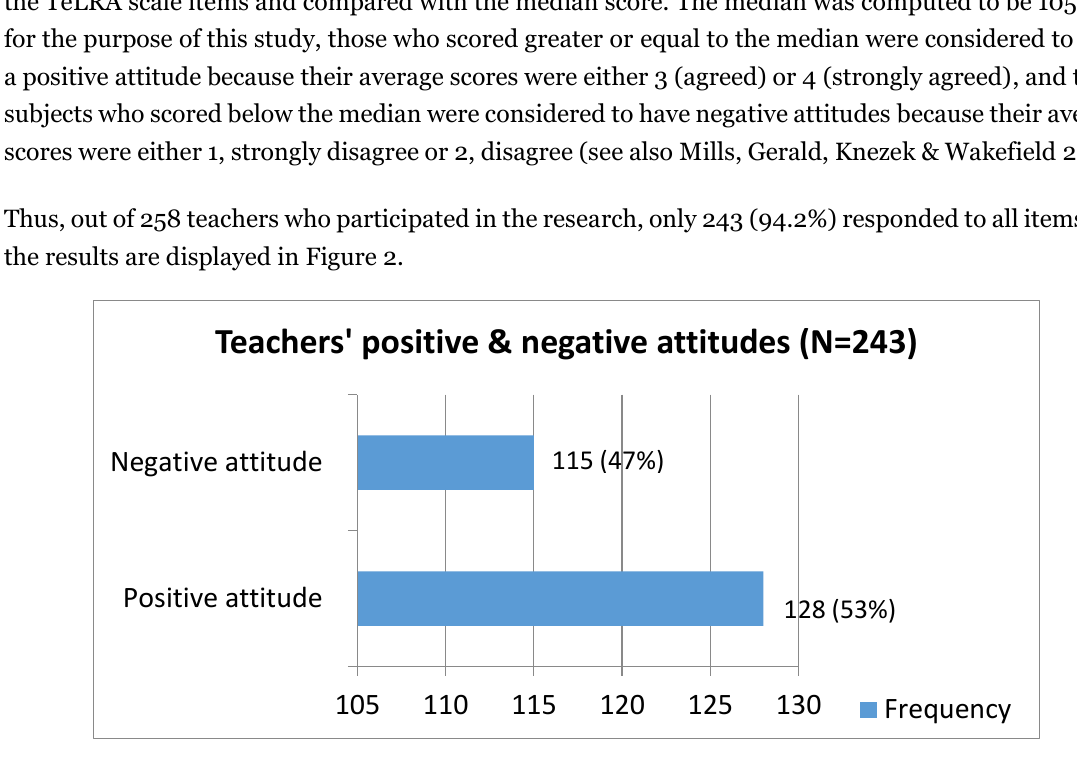
Figure 2. Teachers’ positive and negative